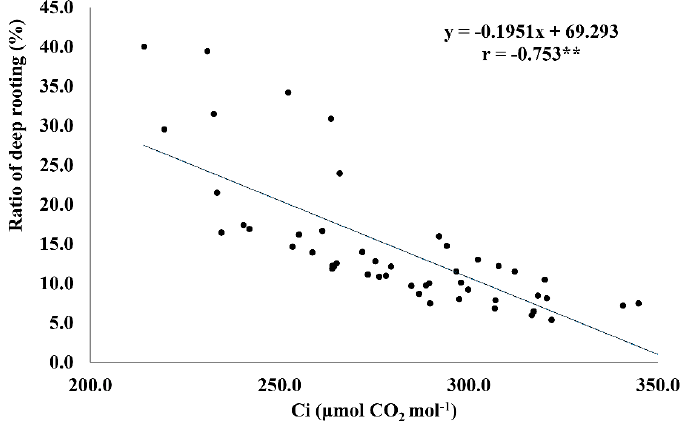
Figure 4. Linear regression relationship between the ratio of deep rooting (RDR) and internal CO 2 concentration under drought conditions. ** <0.01.